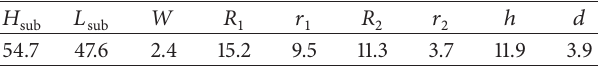
Table 1: Dimensions in millimeters of the geometry illustrated in Figure